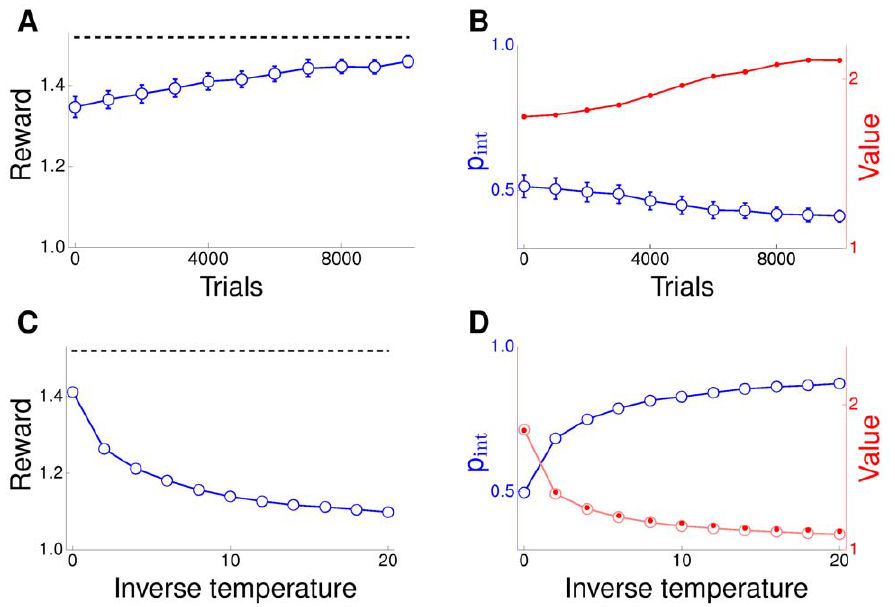
Figure 4. Two armed bandit with intermittent reward. Panels (A) and (B) plot the results for learning with N ~ 135 population neurons and t R ~ 3s . The evolution of average reward per decision is shown in (A) and compared to the reward achievable by the optimal stochastic policy (dashed line). The latter was determined by Monte Carlo simulation. The probability p int of choosing the intermittent target is shown in (B) as well as the value V int , i.e the average reward obtained when choosing the intermittent target with probability p int . Panels (C) and (D) show the asymptotic performance of TD-learning (reached after 1000 trials) for different values of the inverse temperature b . The red empty circles in panel (D) show the estimate of V int computed by the TD-algorithm. The full red circles give the exact value of V int for the choice probability p int used by the TD- algorithm (blue